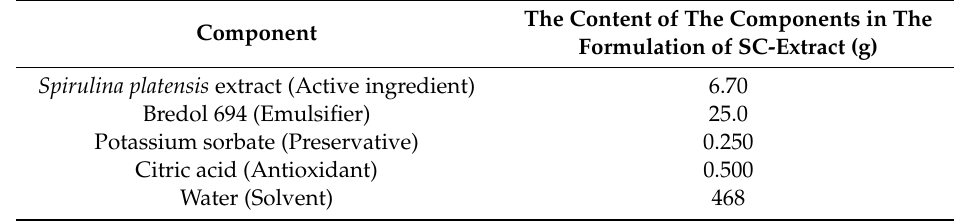
Table 1. The composition of the applied formulation with Spirulina extract (Polish patent application. No P. 412010).